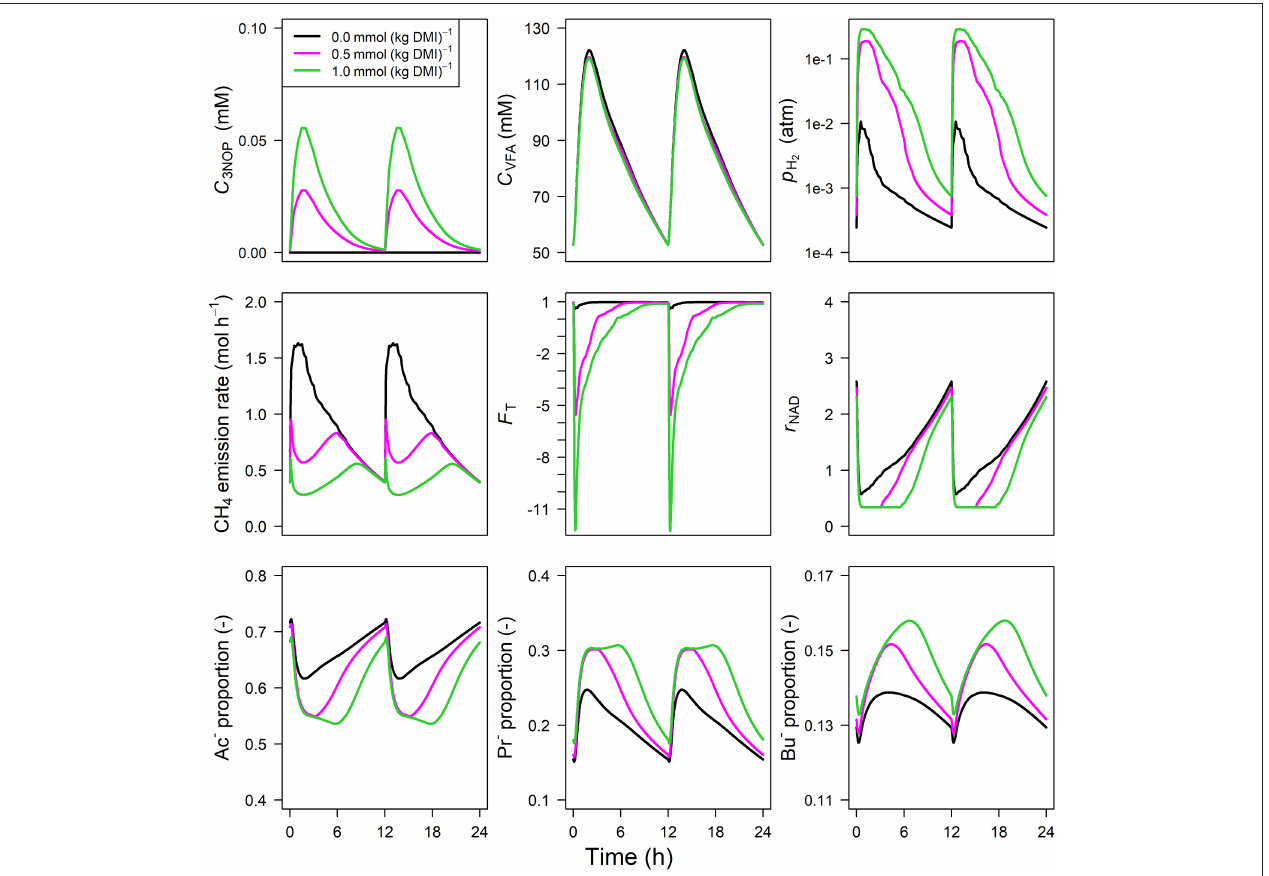
FIGURE 3 | Solutions of the 3-NOP dynamic model without NO – 2 representation [mM], VFA concentration [mM], rumen headspace p H [mol · h − 1 ], thermodynamic potential factor ( F T ; [–]), NAD + to NADH ratio ( r NAD ), acetate proportion (Ac – ), propionate proportion (Pr – ), and butyrate proportion (Bu – ).